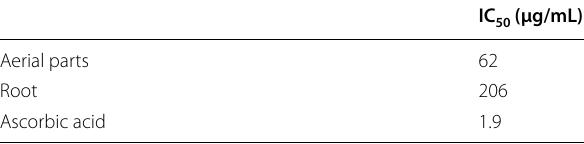
Table 1 IC values of the extracts as determined by DPPH assay 50